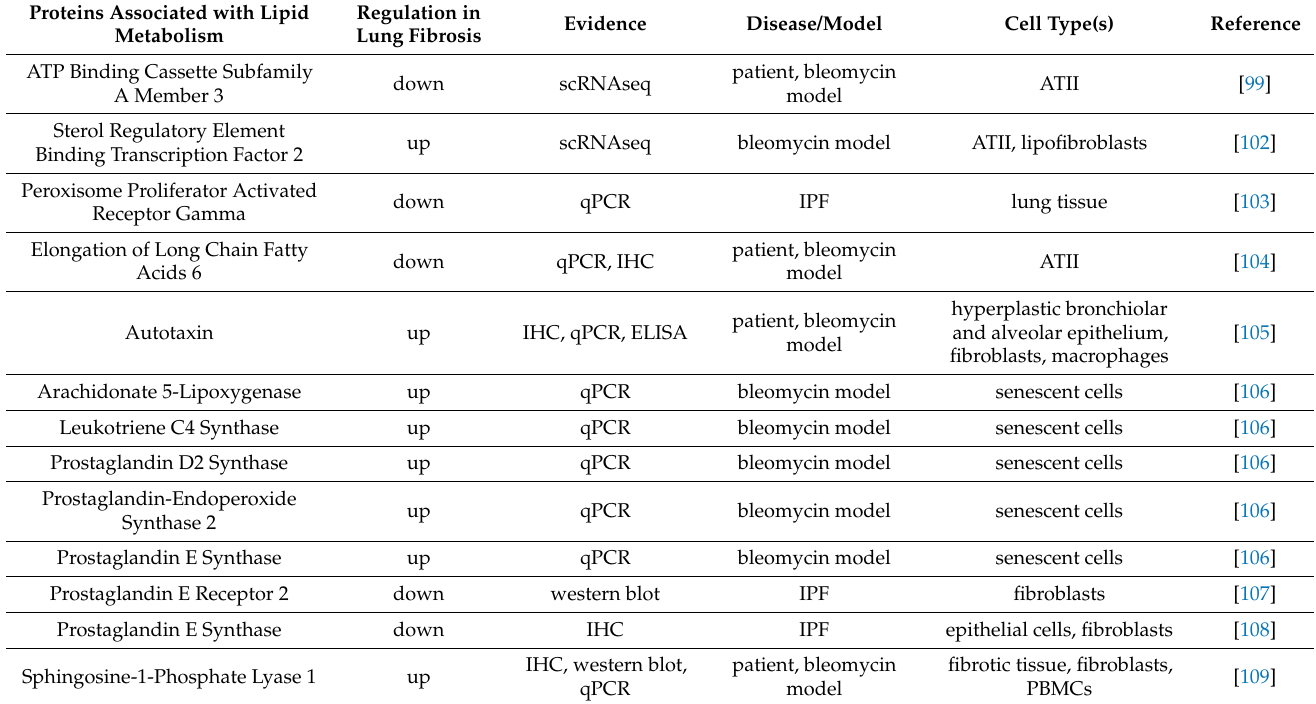
Table 1. Lipid metabolism dysregulation during pulmonary